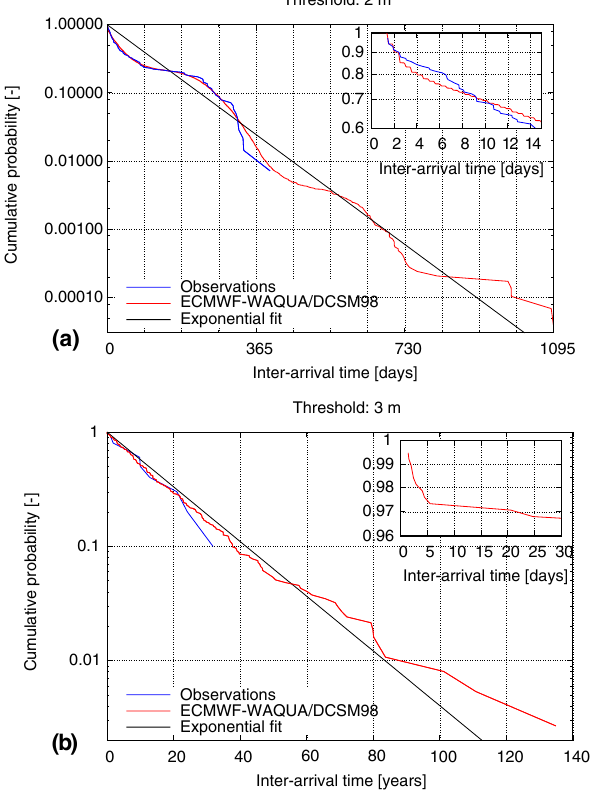
Figure 7. Distributions of the recurrence times of the water level in Hoek van Holland for a threshold of 2m (a) and 3m (b) . The insets show the distribution for the first 14 and 30 days, respectively. The black line represents an exponential fit to the whole dataset. The vertical axes are logarithmic. The blue lines represent the observa- tions.